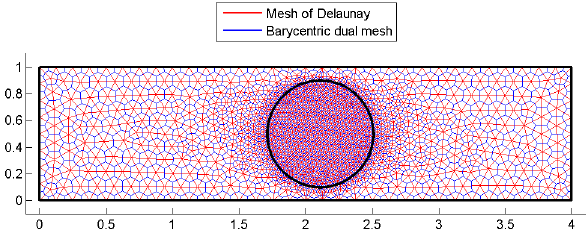
Figure 12: Primal mesh of Delaunay and barycentric dual mesh.